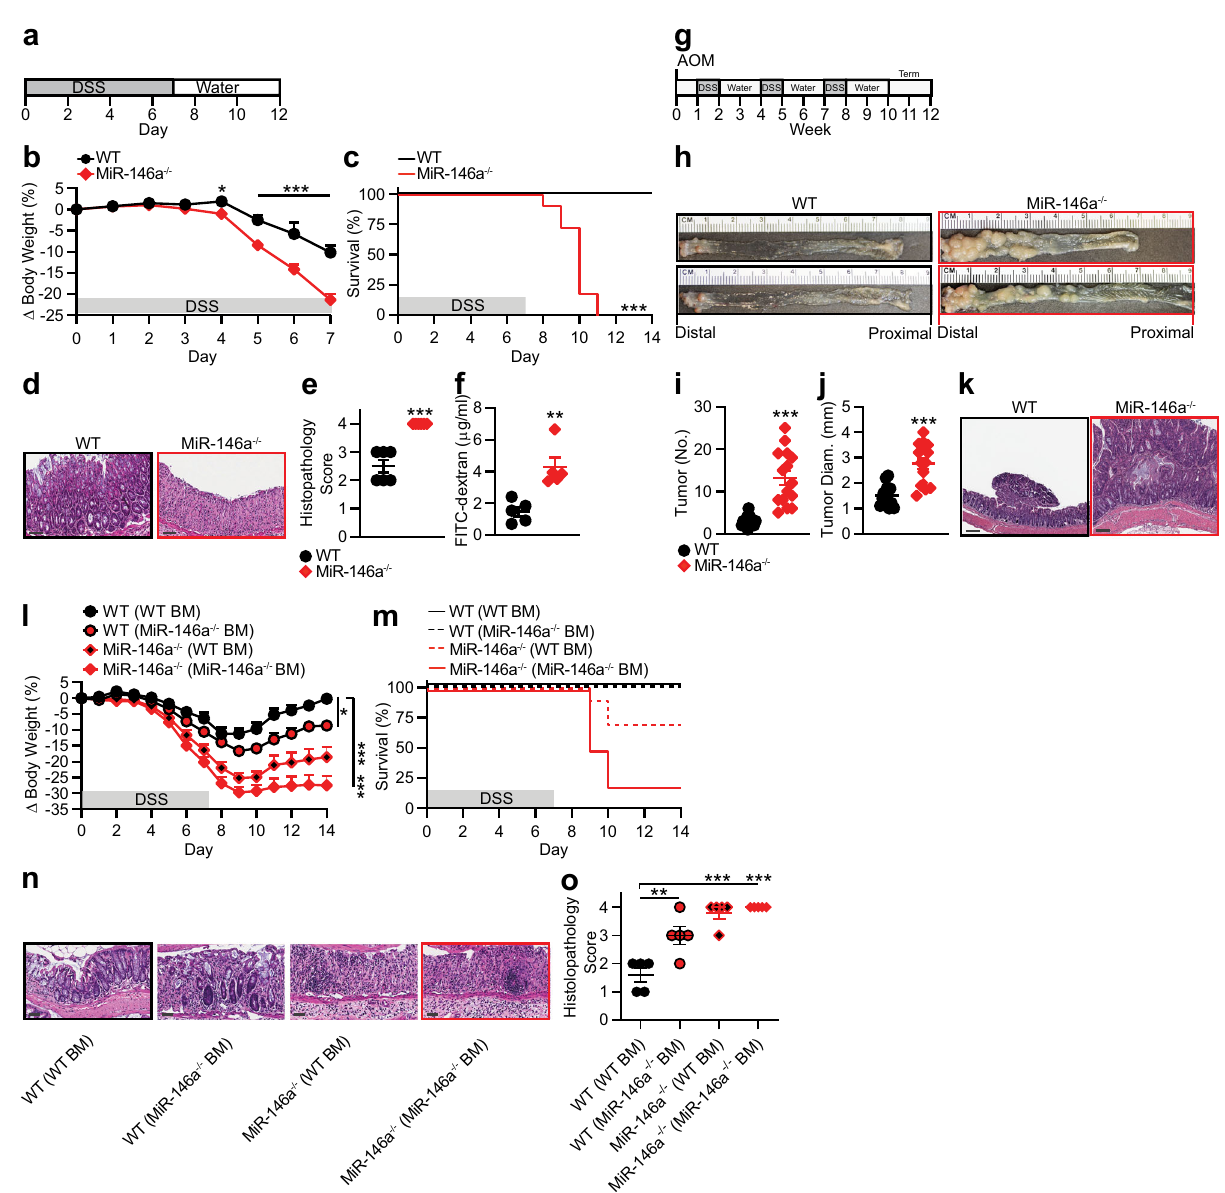
Fig. 1 MiR-146a de fi ciency promotes colonic in fl ammation and colitis-associated colon cancer. a Schematic of DSS colitis induction: 3% DSS was given in water for 7 days, followed by untreated drinking water for 7 days. b , c Percent body weight changes ( n = 15) ( b ) and survival ( n = 11) ( c ) in colitic WT and miR-146a − / − mice. d , e Representative colonic histopathology with H&E staining (scale bar = 50 µ m) ( d ) and histopathological scores ( e ) based on degree of ulceration from colitic mice on day 7 ( n = 6). f FITC-dextran uptake in colitic mice on day 7. Mice were deprived of food and water for 6 h, then given FITC-dextran (400 mg/kg b.w.) by oral gavage. Four hours later, mice were bled and serum was collected. Fluorescence intensity was measured by spectrophotometer ( n = 5). g Schematic of AOM/DSS in fl ammation-associated CRC induction: AOM was given i.p. (10 mg/kg b.w.), followed by 3 cycles of 2% DSS. h – j Representative images ( h ), numbers ( i ), and sizes ( j ) of colonic tumors in WT and miR-146a − / − mice with AOM/DSS-induced CRC ( n = 14 – 15). k Representative colonic histopathology (scale bar = 200 µ m) with H&E staining in WT and miR-146a − / − mice with AOM/DSS-induced CRC. l , m Percent body weight changes ( l ) and survival ( m ) in BM chimeric mice with DSS-induced colitis. WT and miR-146a − / − mice were irradiated and reconstituted with WT or miR-146a − / − BM, for 6 weeks ( n = 9 – 10). Weight changes were compared to WT (WT BM) on day 14. n , o Representative colonic histopathology (scale bar = 50 µ m) stained with H&E ( n ) and histopathological scores ( o ) of colitic chimera mice on day 7 ( n = 5). Comparisons are to WT (WT BM). Data are representative of ≥ 2 independent experiments. n = biologically independent replicates per group. Mean ± SEM. * p < 0.05, ** p < 0.01, *** p < 0.001, by two-way ANOVA with Bonferroni adjustment ( b ), two-way Kaplan – Meier survival analysis ( c ), one-way ANOVA with Dunnett adjustment ( I , o ), or two-tailed Student ’ s t -test ( e , f , i , j ). Source data are provided as a Source data fi